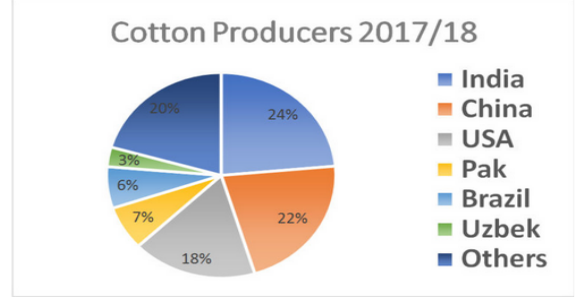
Figure 4: Cotton Analytics from 2017 to